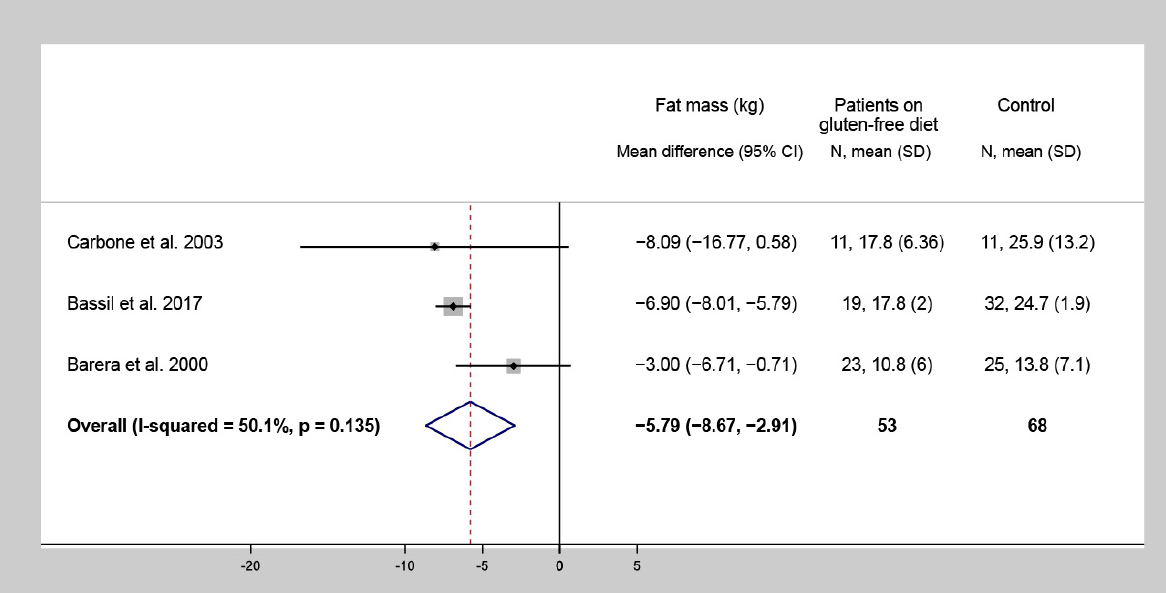
Figure 3. Forest plot of studies comparing fat mass of celiac disease patients on a gluten-free diet for at least one year to that of non-celiac control subjects (a negative number indicates a lower fat mass of the celiac population compared to controls). N: Number of patients.